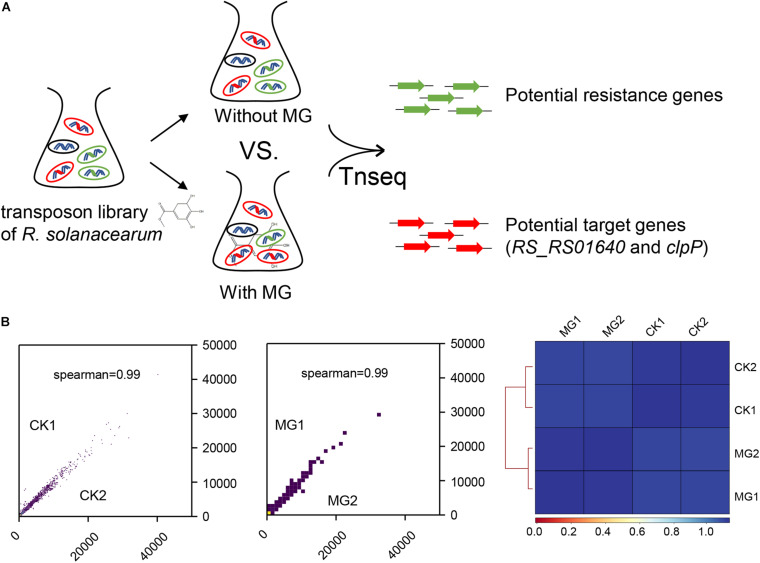
Transposon sequencing (Tn-seq) analysis of gene essentiality for methyl gallate (MG). (A) Schematic diagram of Tn-seq for the identification of resistance genes and target genes for MG. (B) Coefficient of reads coverages for Tn-seq biological replicates (scatter plot) and for all Tn-seq samples (heatmap).